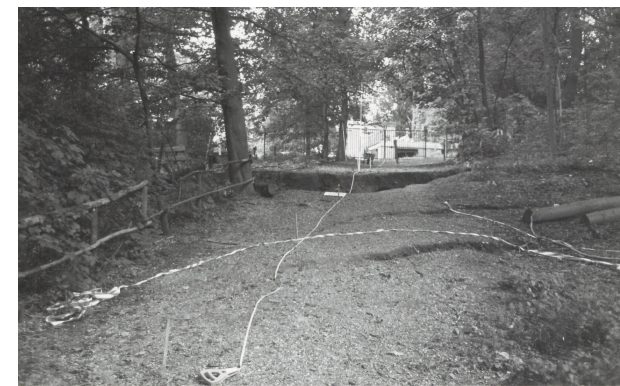
Figure 3. Normal faults on the footpath just north of the restaurant in the background (Courtesy of David George Price).